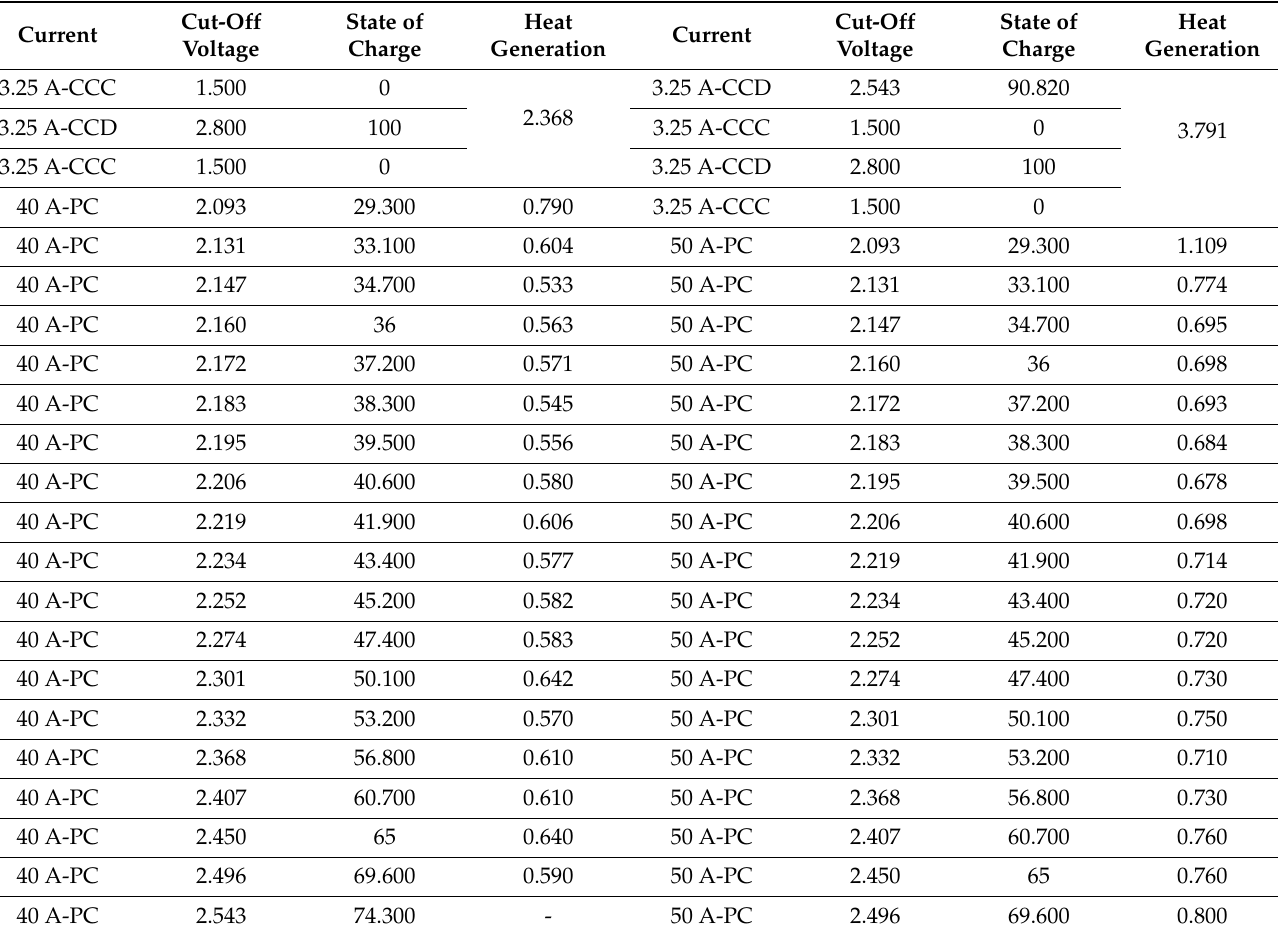
Table 2. Test matrix for Case A.